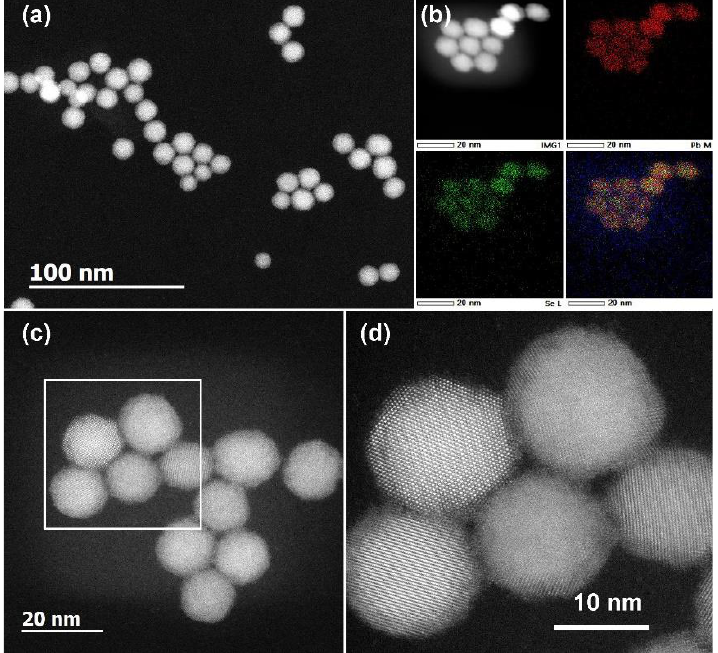
Figure 1. Representative low-magnification ( a , c ) and high-resolution ( d ) HAADF – STEM images of the as-synthesized PbSe QDs, together with the simultaneously collected STEM – EDX elemental maps of Pb, Se, and their mixture ( b ).